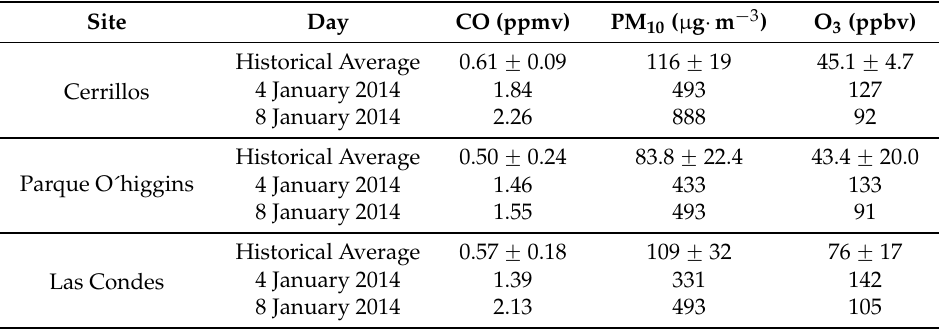
Table 1. Historical average maximum values (January days from years 2011, 2012 and 2013) and maximum values in days with active fires (4 January 2014 and 8 January 2014).